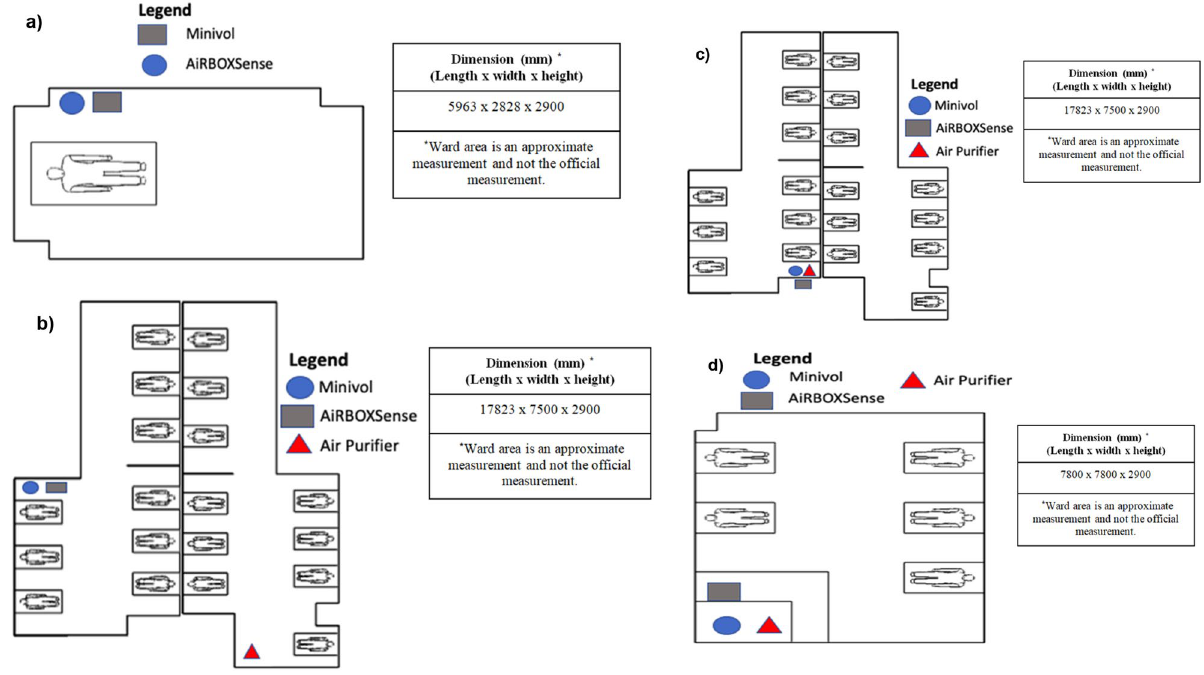
Figure 1. The layout and dimension of the wards with instrumentation deployment a single room A b general ward B, c general ward C and d general ward D. (Note: The beds in the figure does not represent the actual number of beds in the